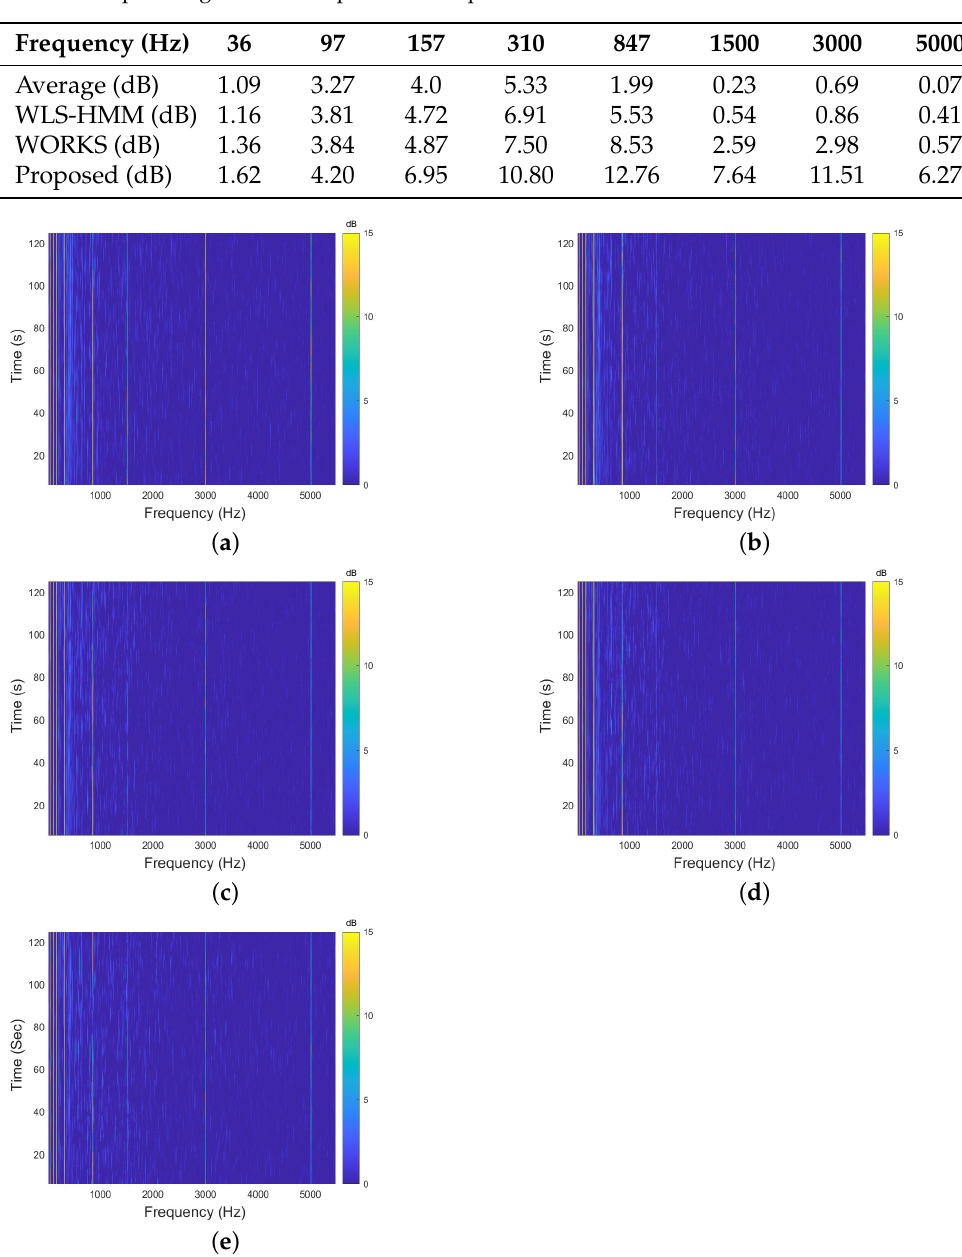
Table 3. Amplitude gains of line-spectrum components.